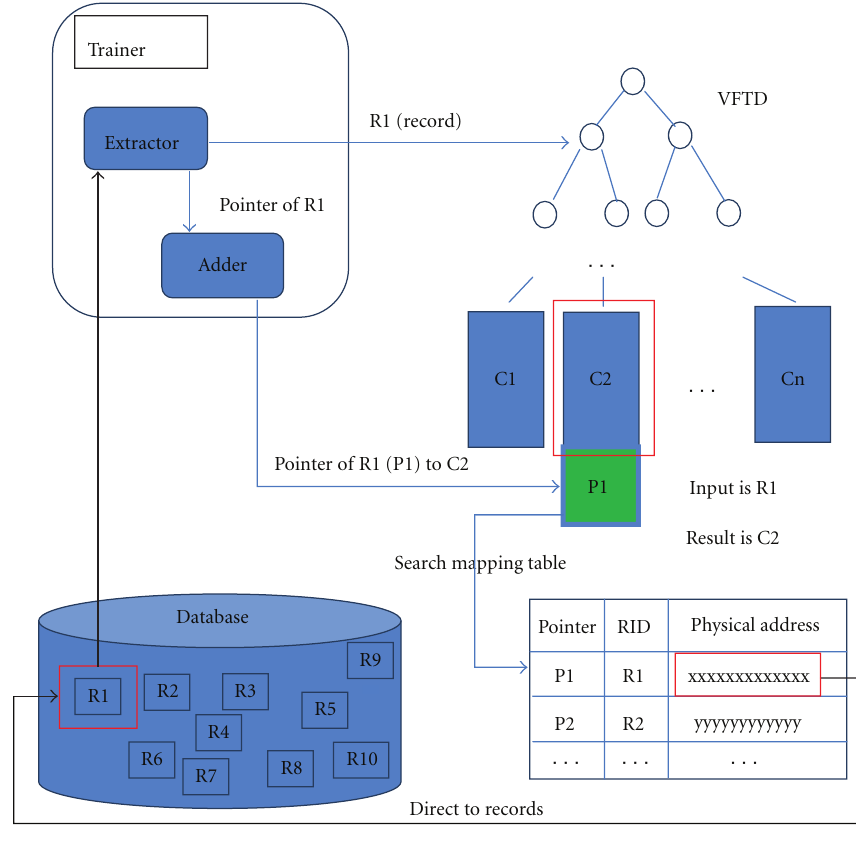
Figure 5: Training and searching process.